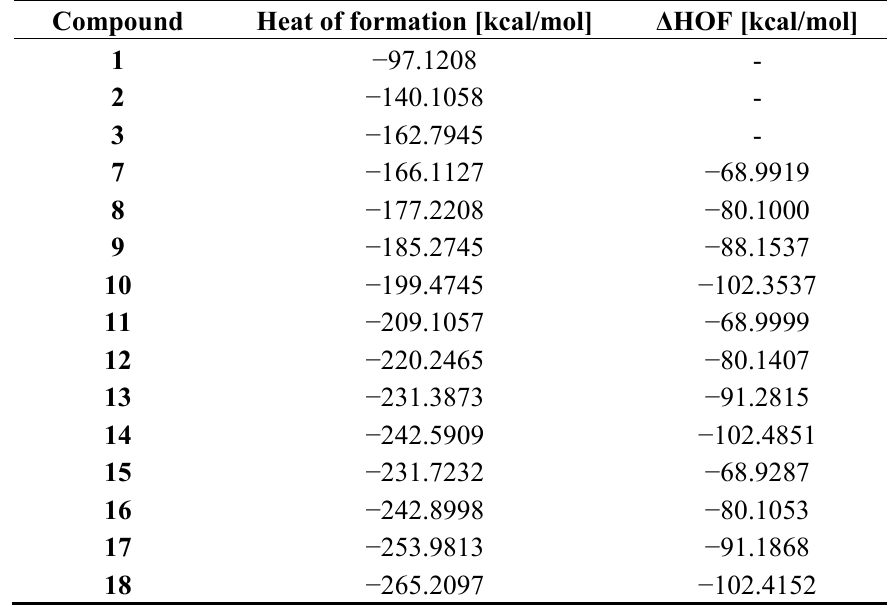
Table 2. Heat of formation (HOF) [kcal/mol] of sterols ( 1 – 3 ) and conjugates ( 7 – 18 ).